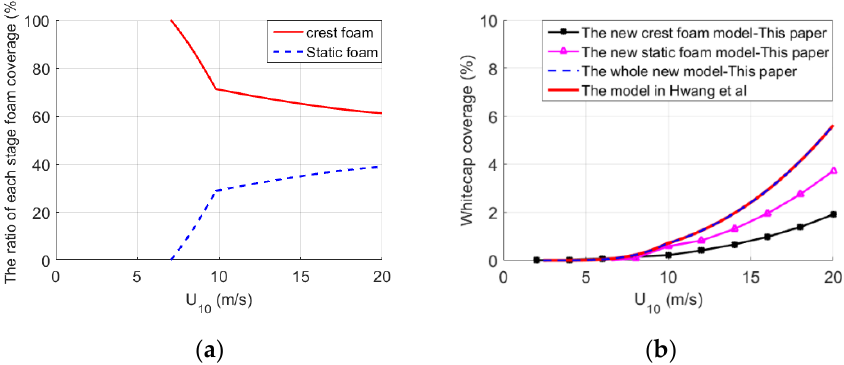
Figure 2. Foam coverage at different wind speeds. ( a ) The ratio of crest foam and static foam. ( b ) Comparison of the Hwang model and the new whitecap coverage summed by crest foam and static foam.